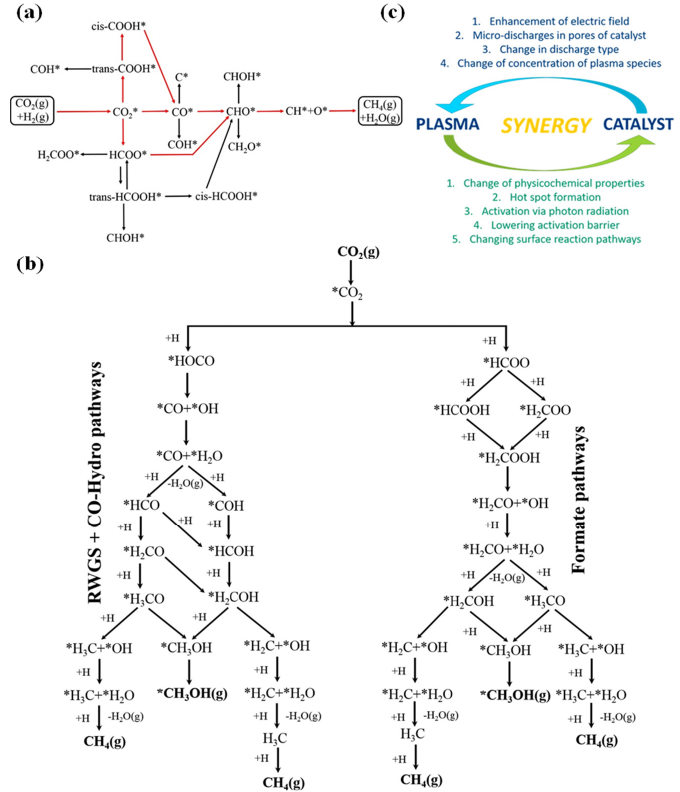
Figure 1. Reaction pathways for ( a ) CO 2 methanation (preferred steps highlighted in red). Reprinted with permission from [40]. Copyright 2018 Elsevier. ( b ) CO 2 hydrogenation to CH 4 and CH 3 OH. Reprinted with permission from [41]. Copyright 2016 Elsevier. ( c ) Synergy in plasma ‒ catalyst sys- tem. Reprinted with permission from [29]. Copyright 2019 Elsevier.